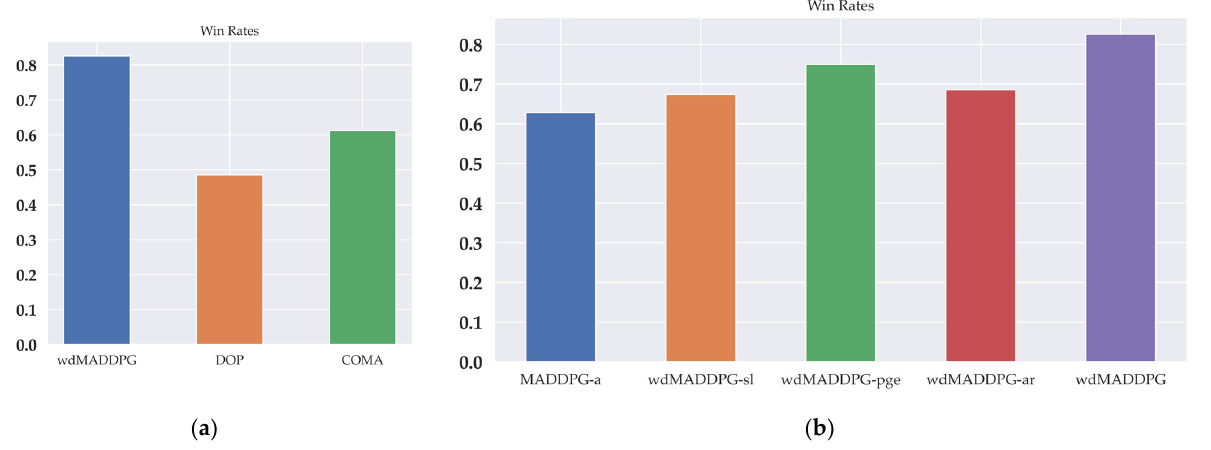
Figure 12. Mean win rates of different models. Each model was tested 500 games of wargame. ( a ) Comparison experiments with other methods based on the AC framework; ( b ) Ablation experiments.